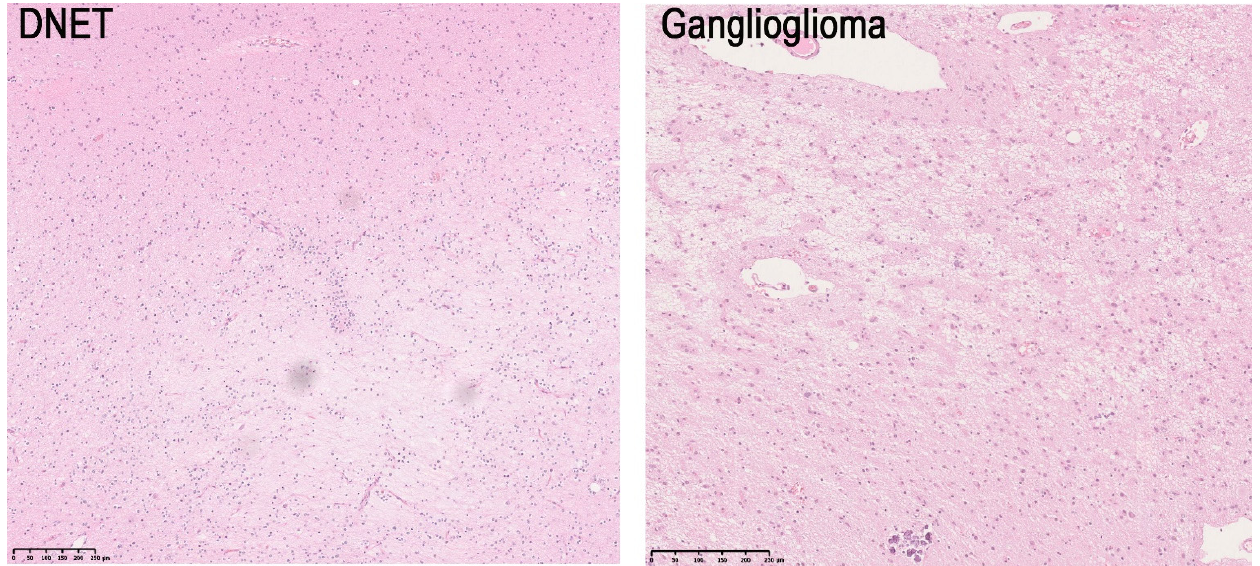
Figure 1. Histopathologic findings in DNET ( left part) and Ganglioglioma ( right part). The histo- morphological pattern can be hard to tell apart in some